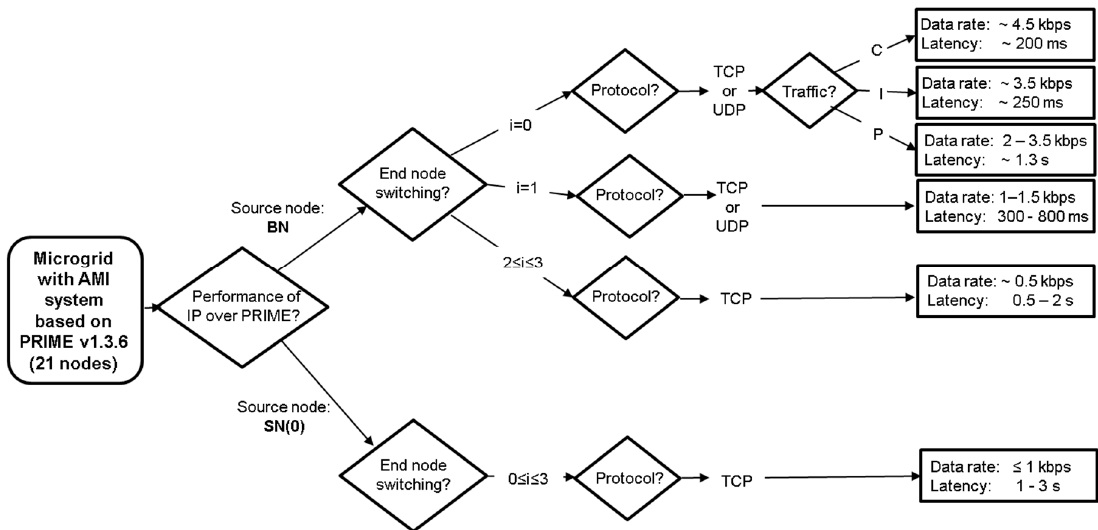
Figure 2. Results from the implementation of IP over PLC-PRIME, in terms of data rate and latency, in a microgrid including an Advanced Metering Infrastructure (AMI) system with 21 nodes. The two main branches differentiate the source nodes (clients in the IP communication). Then, different sub-branches emerge according to the level of switching (i) and the type of traffic: control (C), control+instantaneous (I), and control + profiles (P). Additionally, the suitability of implementing Transmission Control Protocol (TCP) or User Datagram Protocol (UDP) is also shown.